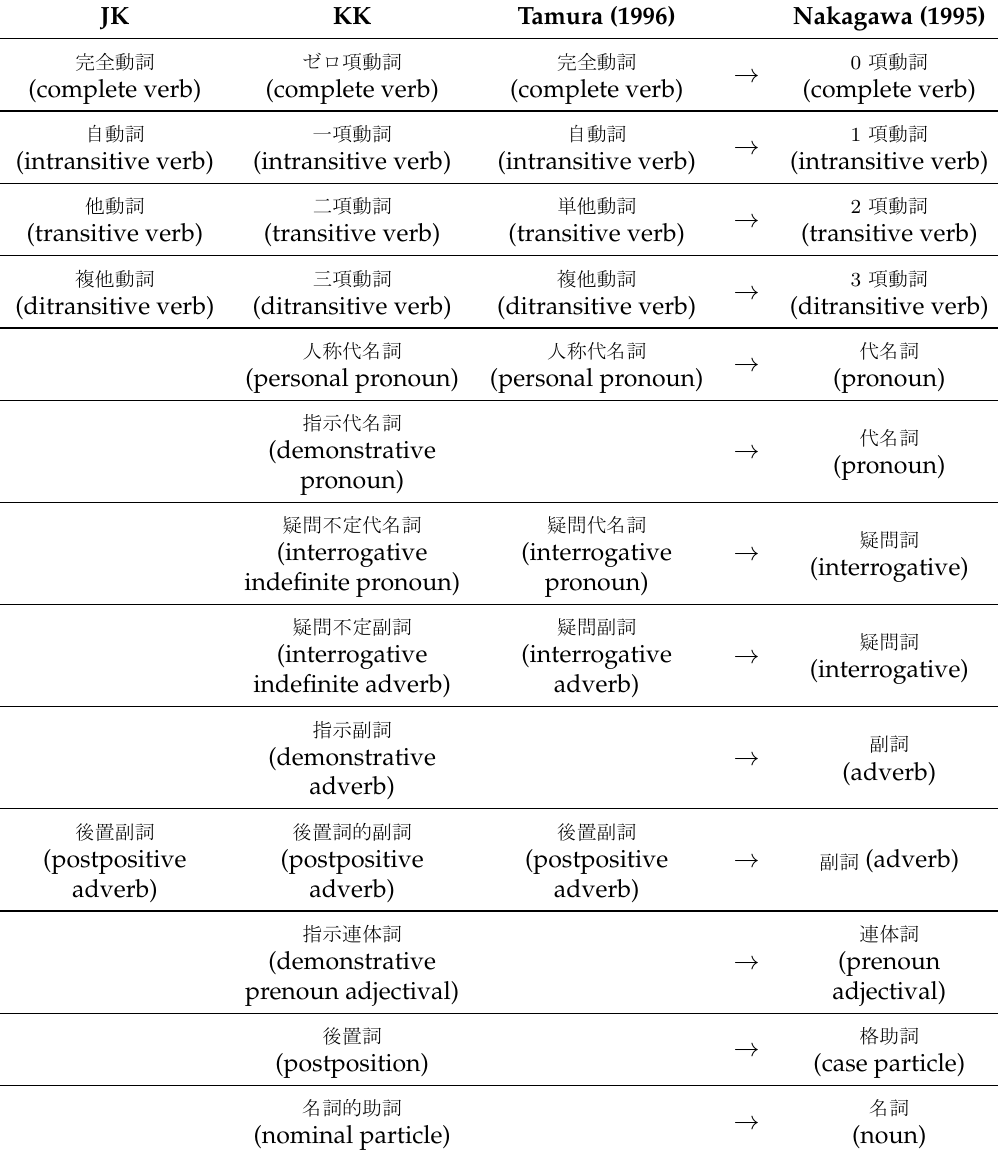
Table 9. Table for conversion of other Ainu part-of-speech standards into Nakagawa’s standard. JK